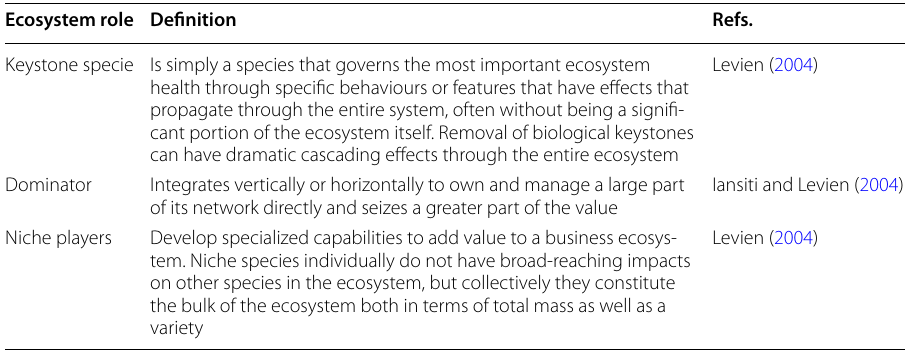
Table 2 Three types of roles in business ecosystems Ecosystem role Definition